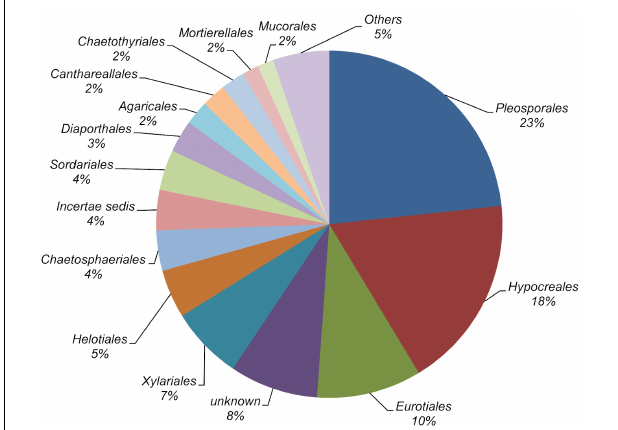
FIGURE 2 | Rank-abundance plot showing the incidence in plants of each taxon identified in roots of Festuca rubra subsp. pruinosa plants from marine cliffs in northern